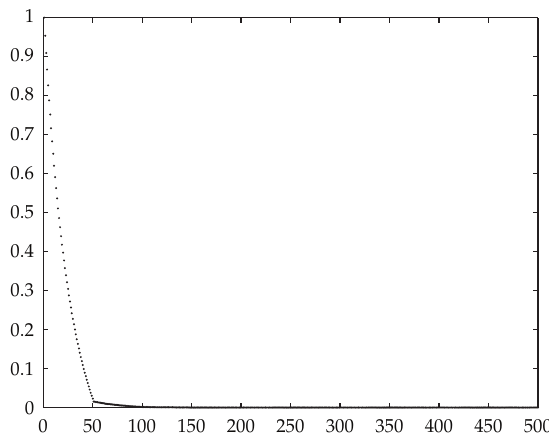
Figure 5: One-leg θ -method with θ (cid:6) 0 for (cid:4) 5.3 (cid:5)